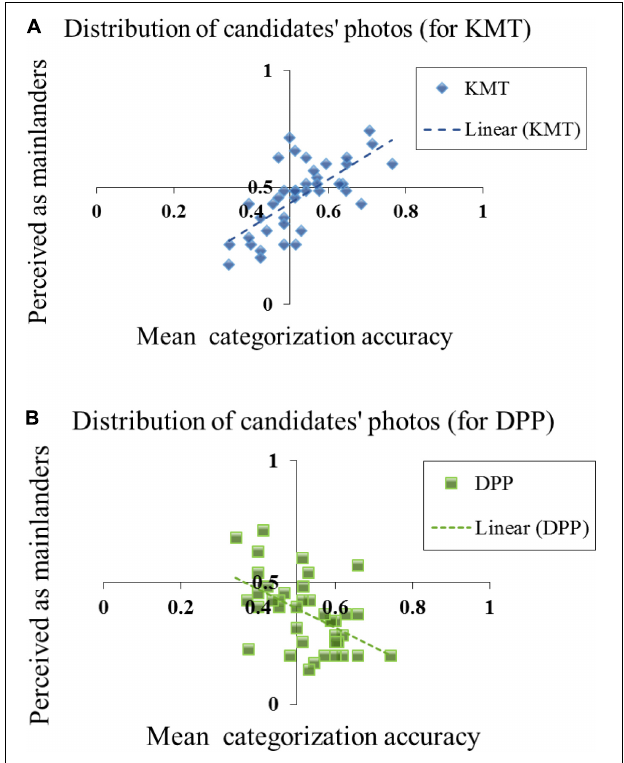
FIGURE 7 | The scatter plots of the accuracy of political membership categorization task ( x -axis) as a function of provincial appearance categorization tendencies ( y -axis) as mainlanders for each candidate’s photo from KMT (A) and DPP members (B) . The abscissa denotes the accuracy of categorization. The ordinate represents the percentage of perceived as mainlanders. A candidate’s photo falls above 0.5 means that more than half of the participants perceive the photo as resembling mainlander. A photo falls below 0.5 means that more than half of the participants perceive the photo as resembling native